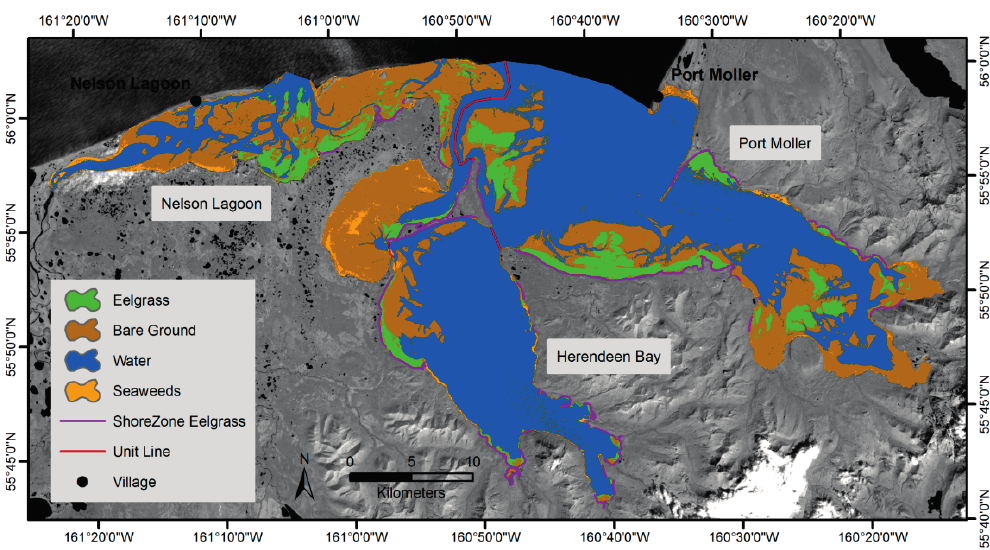
Figure 5. Distribution of eelgrass and other habitats as derived from Landsat imagery (displayed as a black/grayscale backdrop) in Port Moller, Herendeen Bay, and Nelson Lagoon using ShoreZone data to differentiate between eelgrass beds and